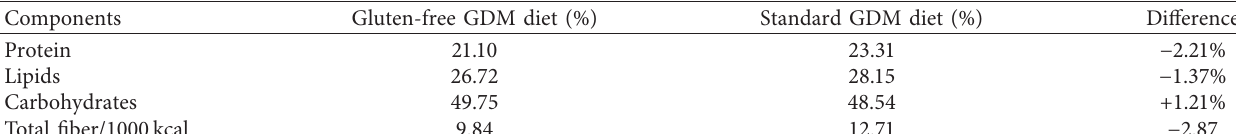
Table 2: Composition of macronutrients in the diet of women with vs without CD.